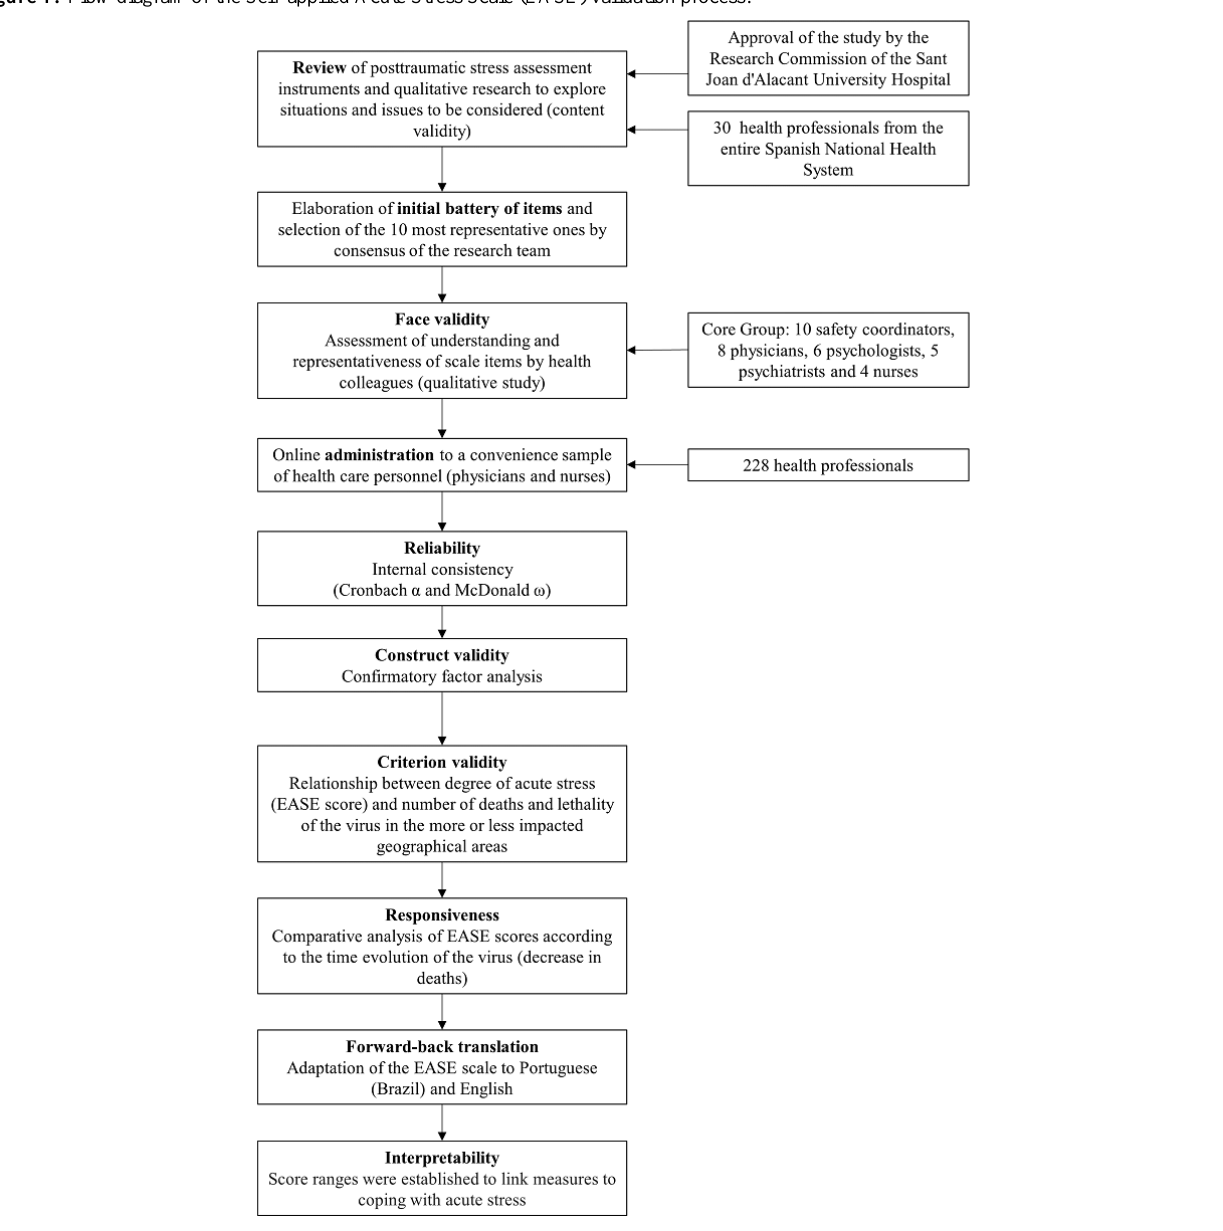
Figure 1. Flow diagram of the Self-applied Acute Stress Scale (EASE) validation